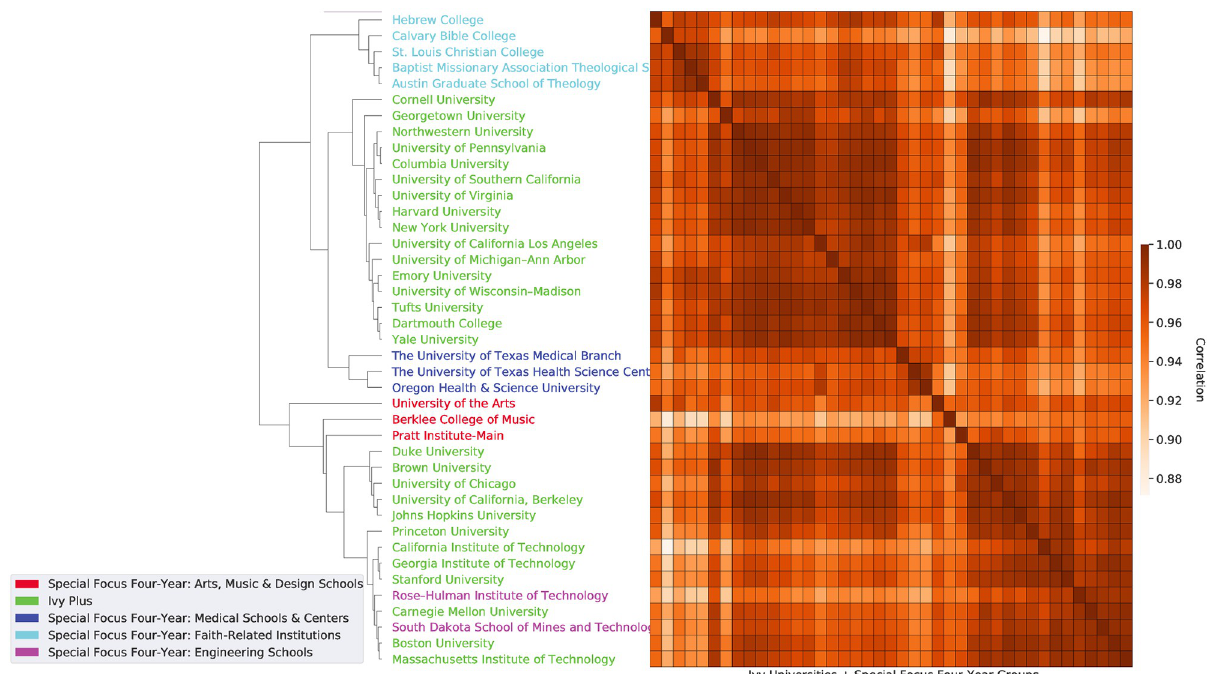
Fig 3. The similarity of universities based on the graduation-weighted prevalence of DWAs offered in their course syllabi. The dendrogram and heatmap reveals the hierarchical clustering of the Ivy Plus group and Special Focus Four-Year groups from the Carnegie Classification 2018 based on DWA vector